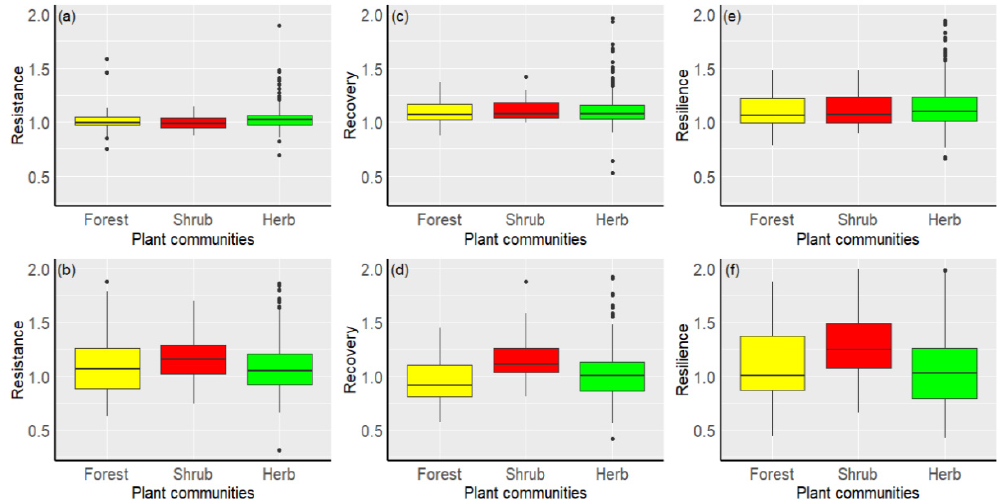
Figure 5. The changes in resistance, recovery, and resilience of the different plant communities under different drought intensities; ( a , c , e ) represent moderate to severe drought conditions (MSD); ( b , d , f ) represent climatic extreme drought conditions and hydrologic wet conditions (CED + HW).